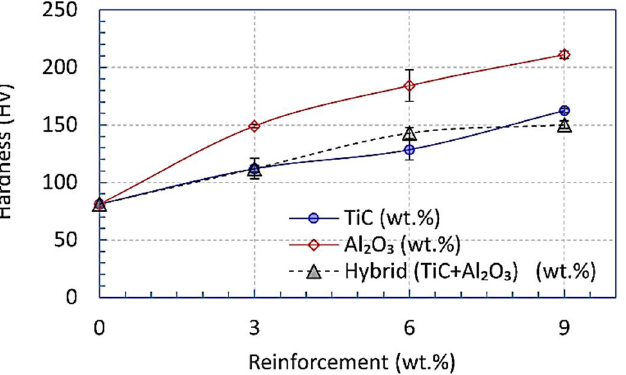
Figure 11. A diagram of the measured hardness for copper-based nanoceramics.